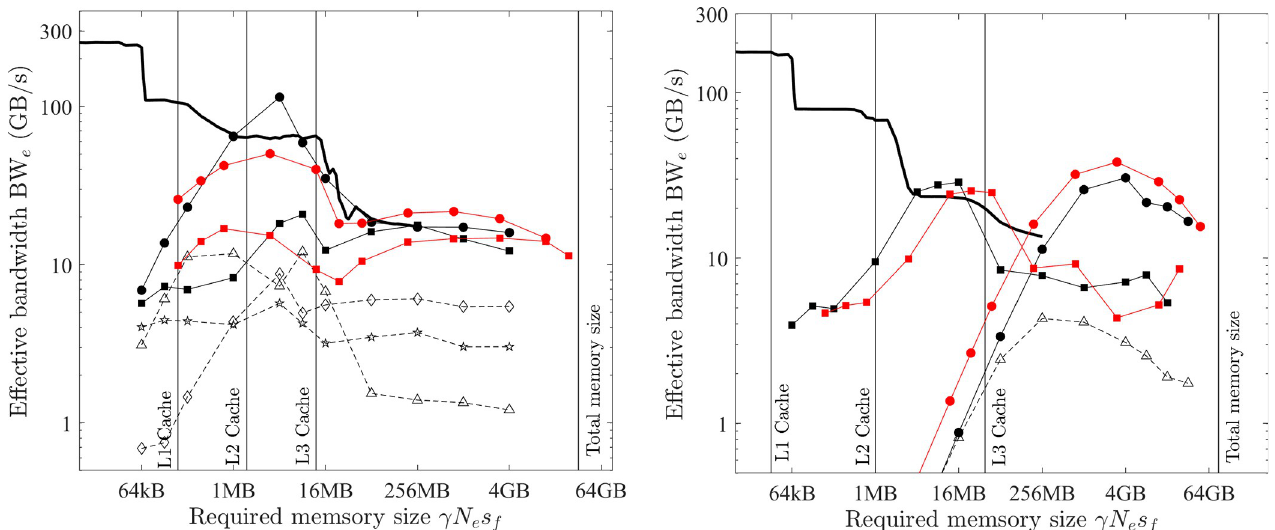
Fig 18. Optimal implementation of HEAT2D and NS2D on the CPU platform (double precision; solid black line = benchmarked bandwidth; lines + symbols = effective bandwidth; black = HEAT2D; red = NS2D; filled circles = OpenMP parallel for with cached access; hollow triangles = OpenMP parallel for with uncached access; filled squares = XLA with slice and concatenation; hollow diamonds = XLA with convolution; hollow pentagons = XLA with roll). (a) PC. (b) HPC.